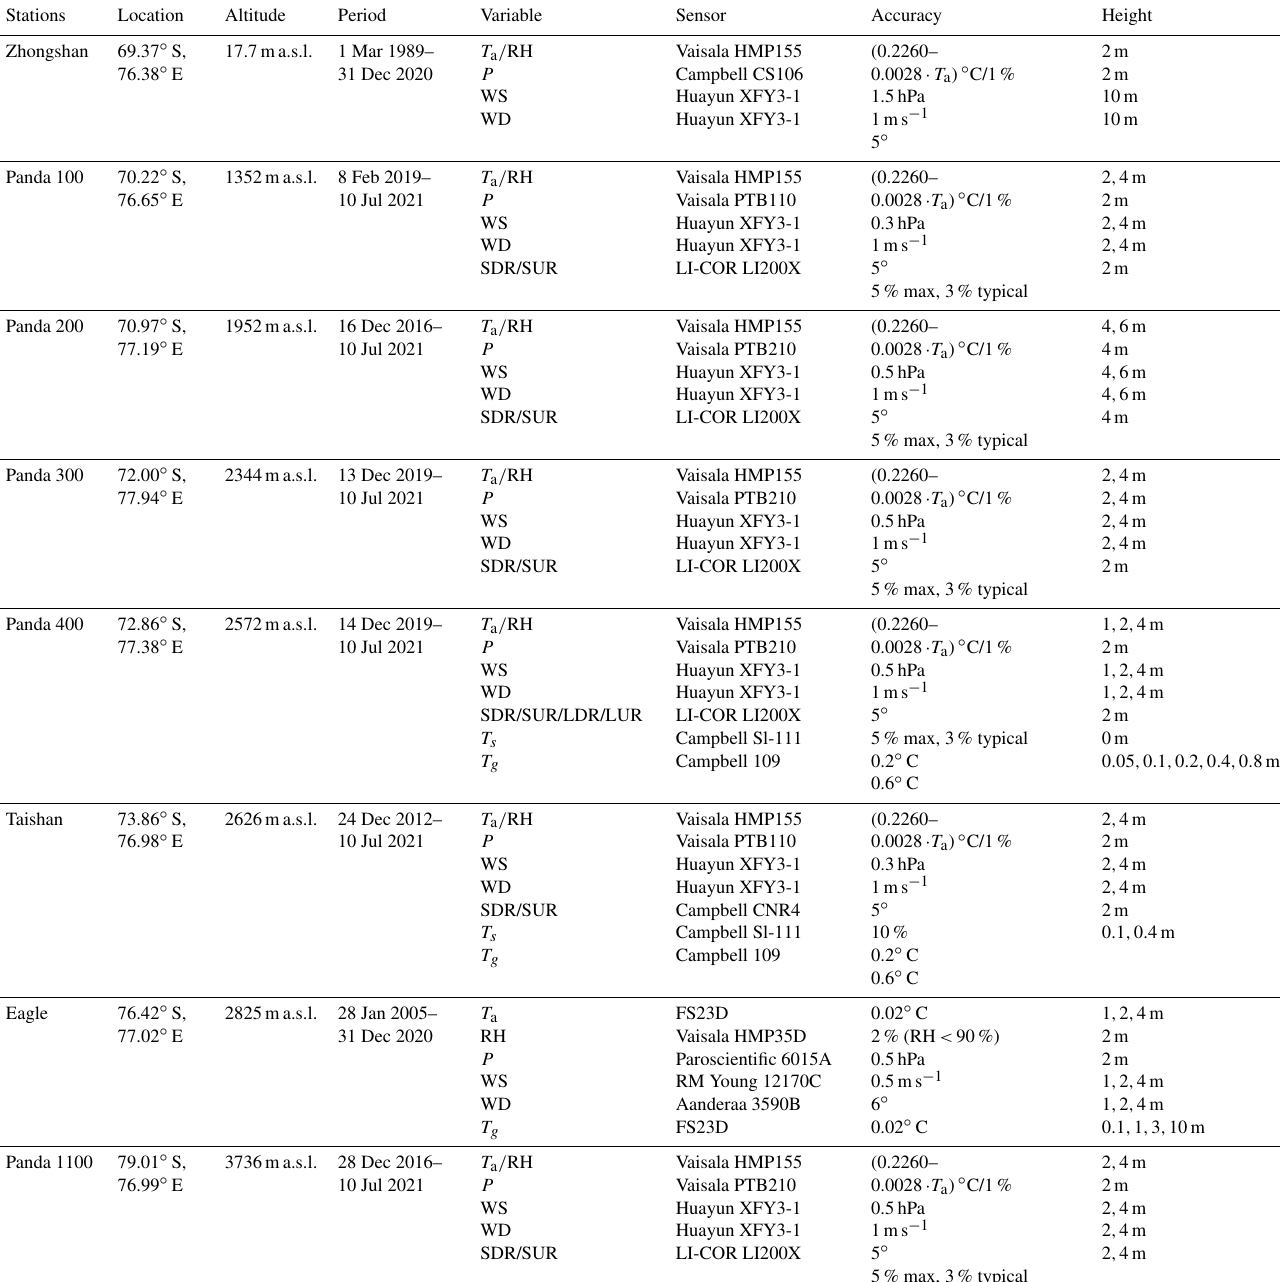
Table 1. Locations, operational periods, observed variables and heights, and instrumentation and accuracies of AWSs in the PANDA network.